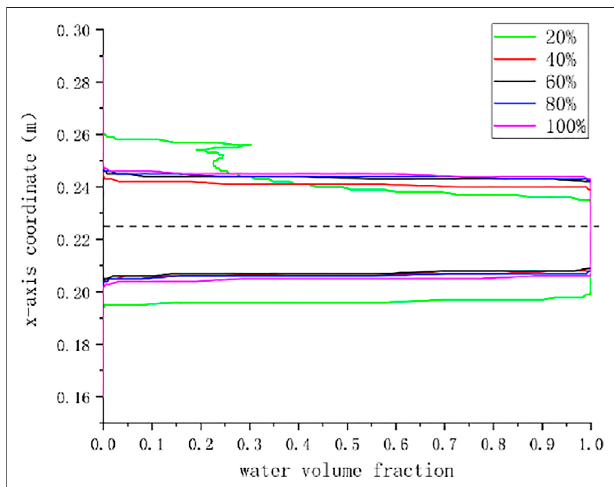
FIGURE 7 | The eccentric jet state on the z = 0 mm straight line on the y = 30 mm section under different